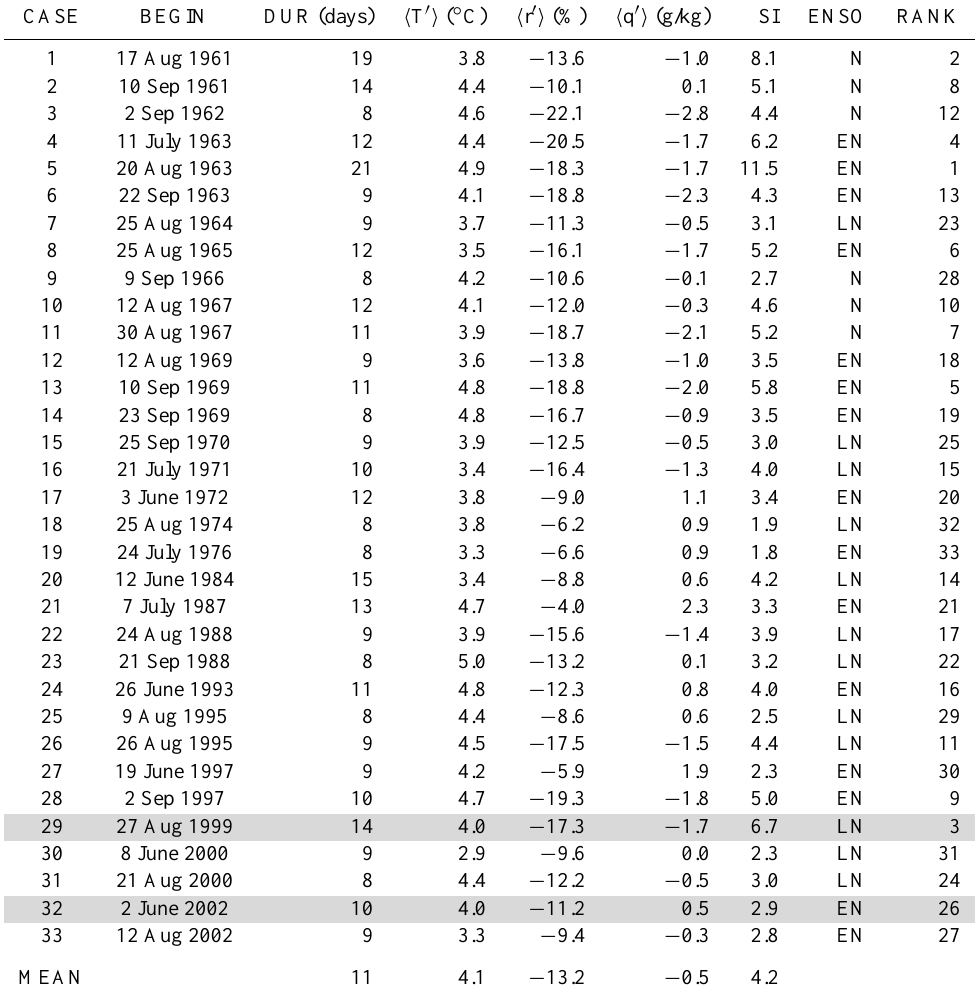
Table 1. Characteristics of Warm and Dry Spells (WDS) in the period 1961–2003. BEGIN: beginning date. DUR: duration in days. h T 0 i , h r 0 i , h q 0 i : episode-mean anomalies averaged over the target area of temperature, relative humidity and specific humidity, respectively, at 1000hPa. SI: severity index. EN, LN, N indicate ENSO phases, El Ni˜no, La Ni˜na and normal years, respectively. RANK is the order of the event in terms of SI. WDSs used in case studies are